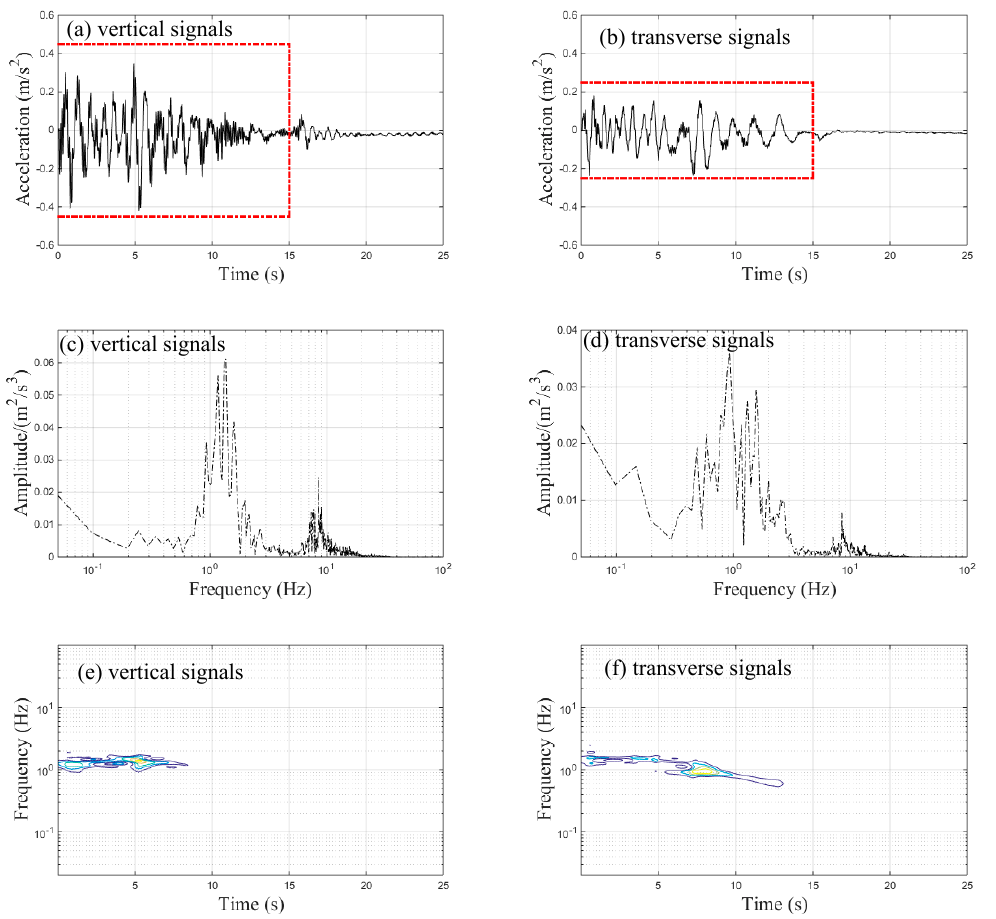
Figure 8. Acceleration signals of the car body during braking: ( a ) time-history data of vertical signals; ( b ) time-history data of transverse signals; ( c ) FFT results of vertical signals; ( d ) FFT results of transverse signals; ( e ) TFRs of vertical signals; ( f ) TFRs of transverse signals.